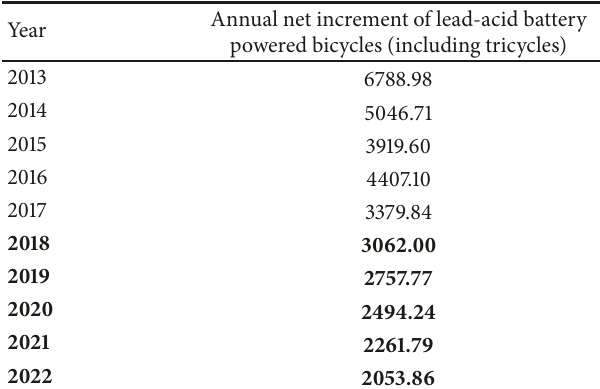
Table 8: Annual net increment of lead-acid battery powered bicycles (including tricycles) in 2018-2022 (unit: 10,000